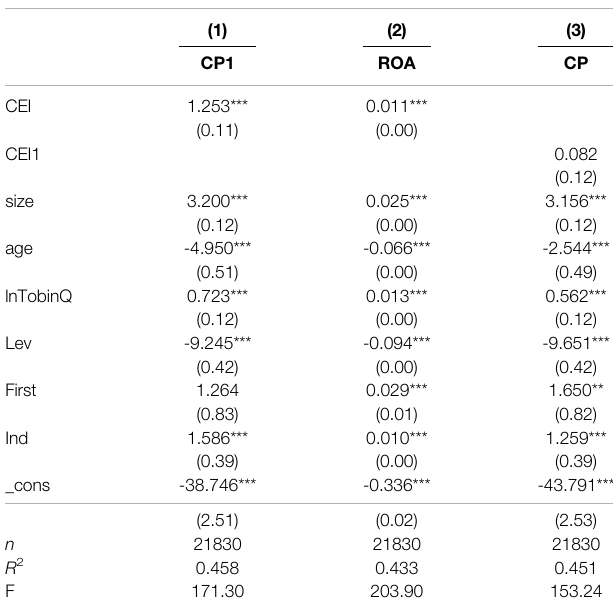
TABLE 13 | Parallel trend test. TABLE 14 | Robustness